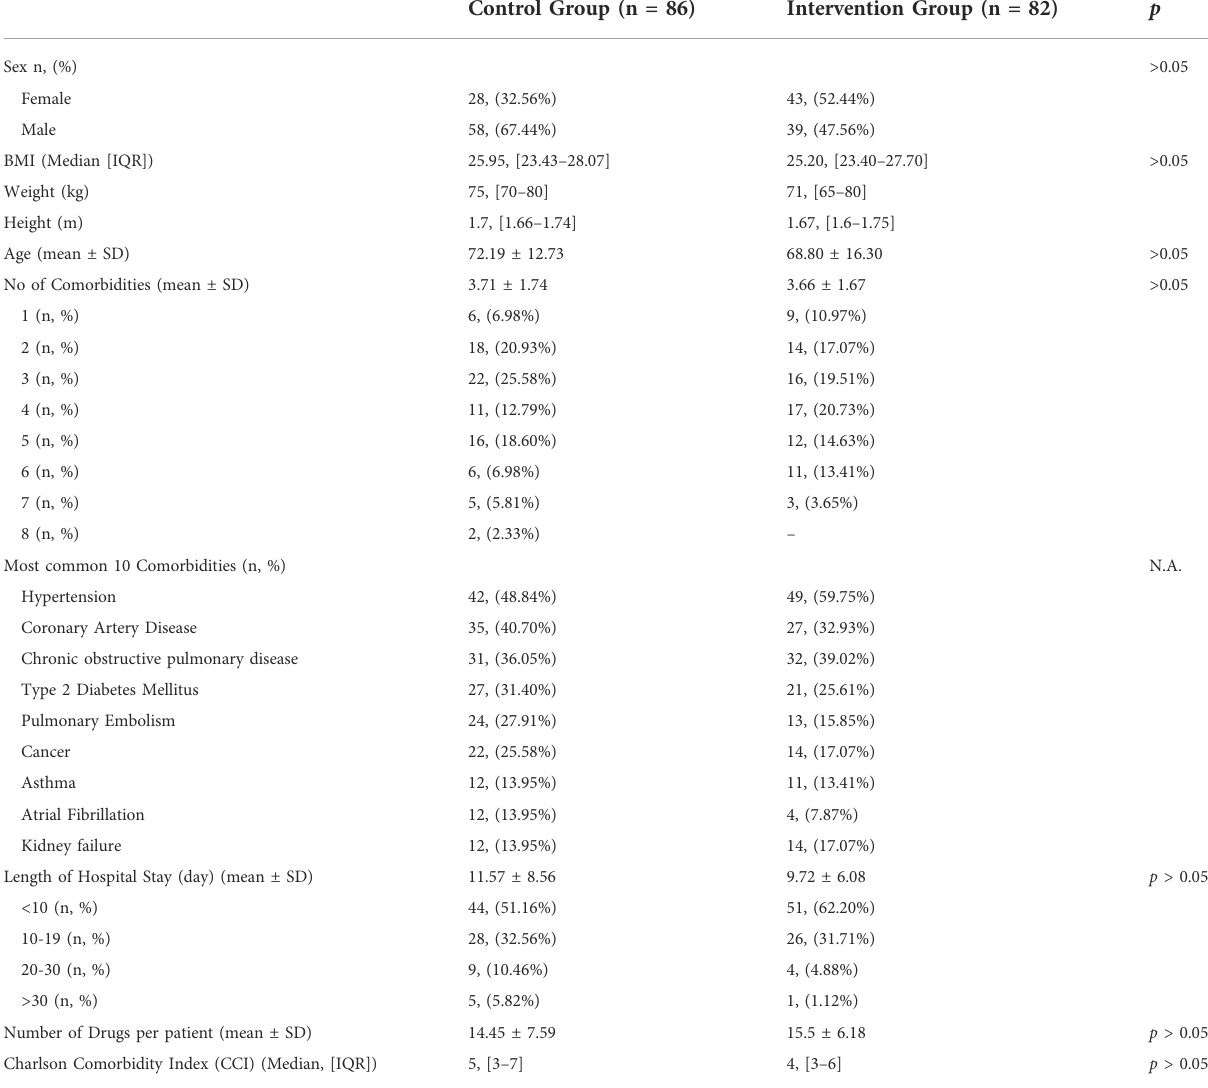
TABLE 2 Patient